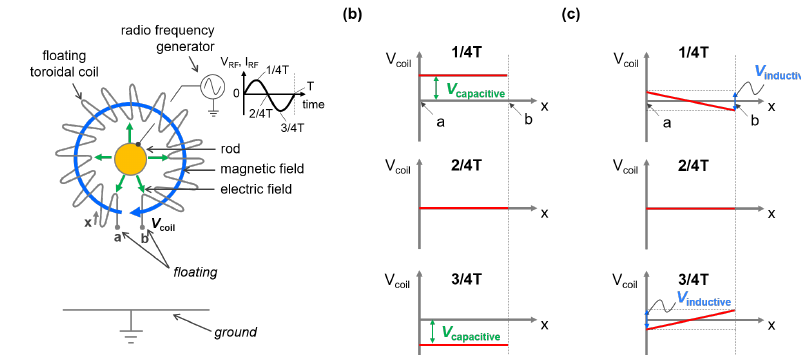
Figure 1. ( a ) Schematic of a floating toroidal coil (FTC). ( b , c ) Voltage of the FTC ( V coil ) when only radio frequency (RF) voltage is applied ( b ) and when only RF current flows through the rod ( c ) at different RF phases (1/4T, 2/4T, and 3/4T), where the T is the period of the RF